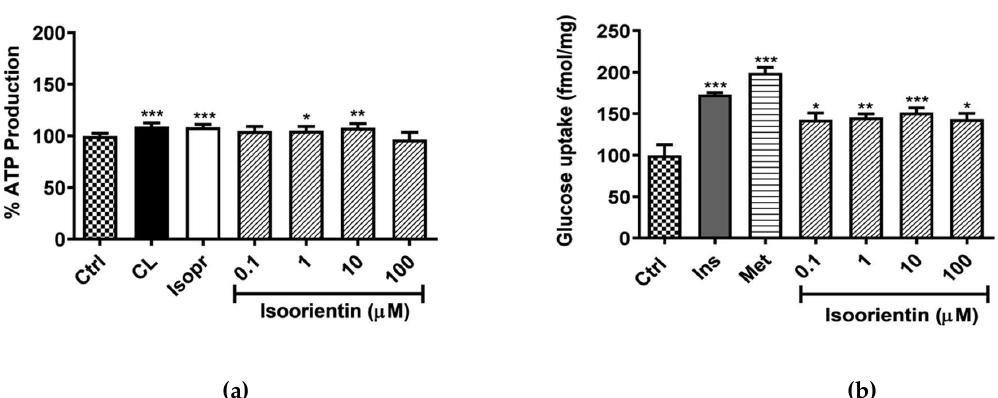
Figure 1. Isoorientin increased ATP production ( a ) and glucose uptake ( b ) in fully differentiated 3T3-L1 adipocytes. Mature 3T3-L1 adipocytes were treated with or without positive control CL-316,243 (CL), isoproterenol (Isopr), insulin (Ins), metformin (Met) used at 1 μM and various doses of isoorientin (0.1, 1, 10, and 100 μM) for 4 hours. Results are expressed as mean ± SEM of three independent experiments. * p < 0.05, ** p ˂ 0.01, *** p ˂ 0.001 versus normal control (Ctrl).